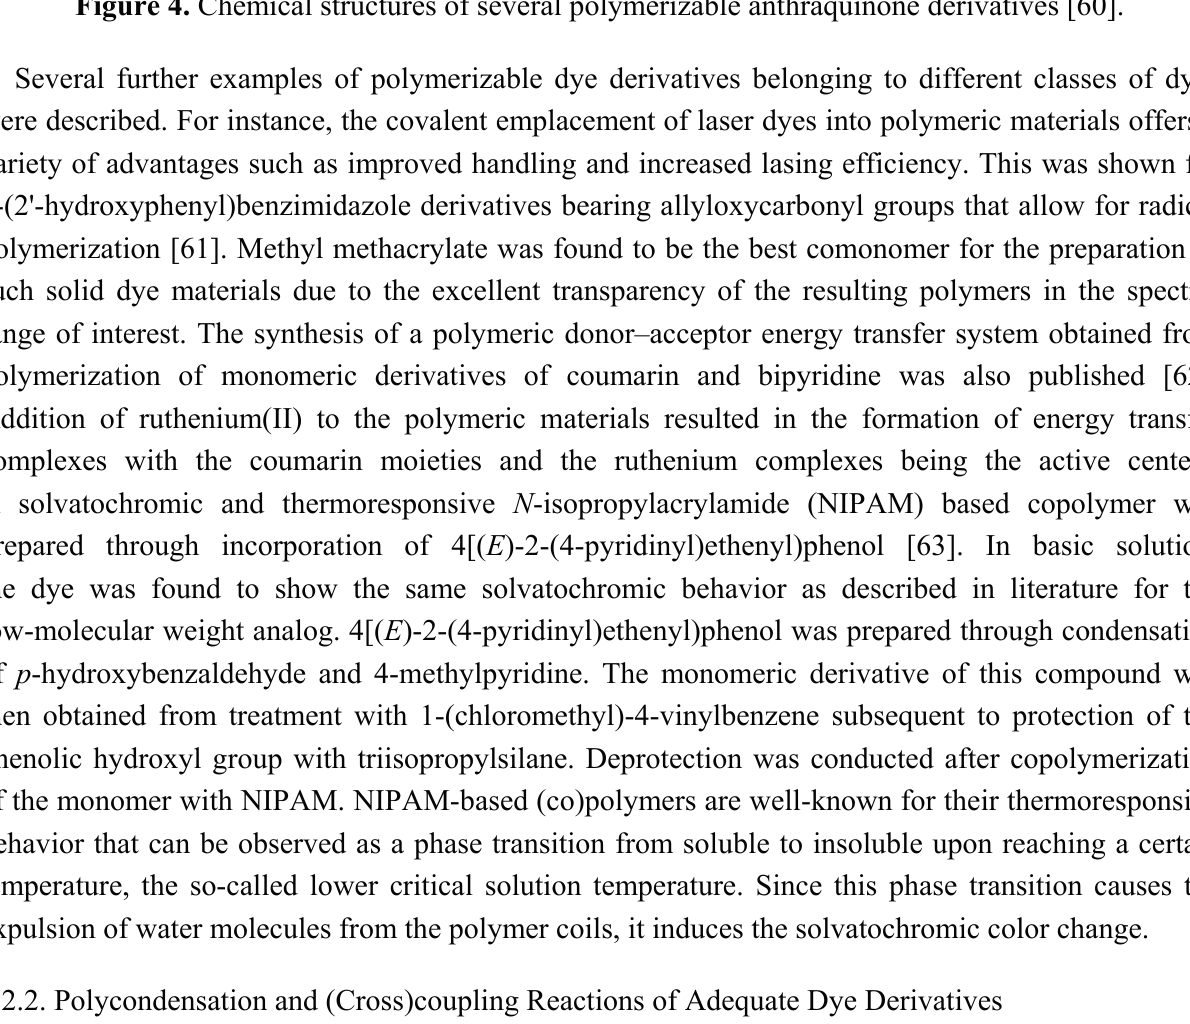
Figure 4. Chemical structures of several polymerizable anthraquinone derivatives